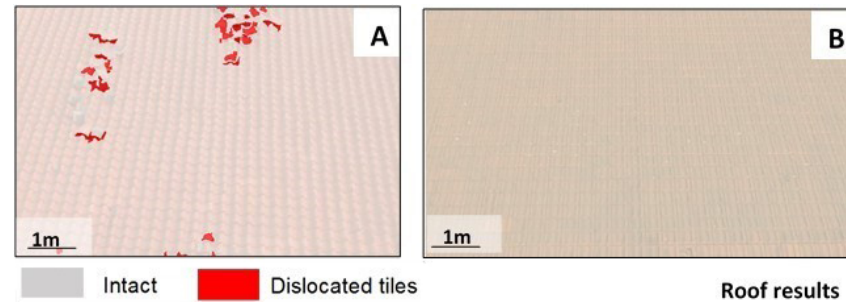
Figure 7. Result of applying the roof rule set on two roof images. Scale